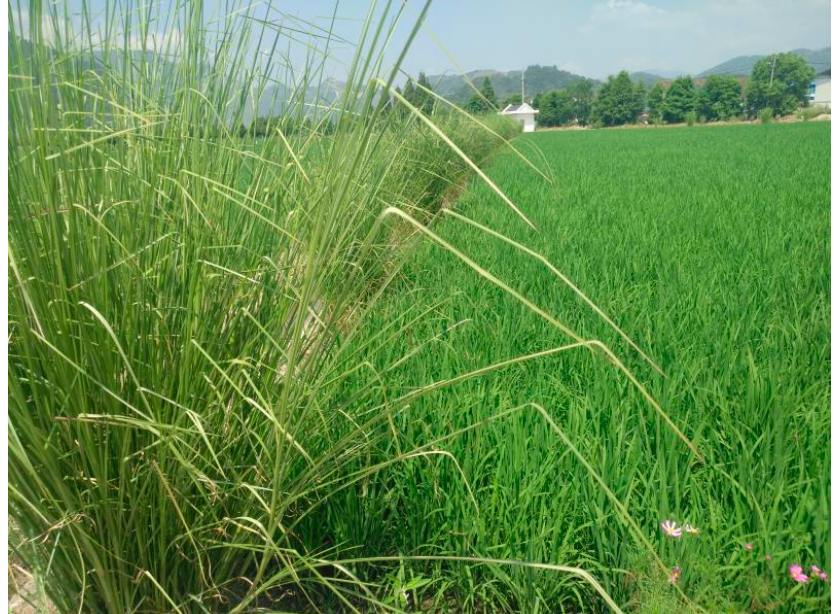
Figure 3. Vetiver planted on the bunds (left) as a traps crop for rice stem borer management in China. Photo taken in 2018 by LXZ.